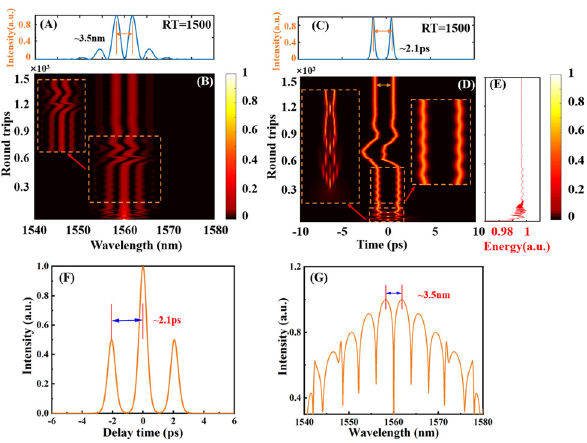
Figure 8: Numerical simulation results of soliton molecules dynamics in 1500 consecutive RTs. (A) Spectral profile with RT = 1500, (B) Spatio-spectral dynamics. Inset: local magni fi cation of the spectral domain. (C) Pulse pro fi le with RT = 1500. (D) Spatio-temporal dynamics. Inset: local magni fi cation in the soliton interactions and vibration. (E) Pulse energy evolution diagram. (F) Pulse autocorrelation trace diagram with RT = 1500. (G) Spectral pro fi le with RT = 1500 (log scale). Figure 8(D) that a single pulse is gradually split into mul- tiple sub-pulses, and experienced multiple splits and